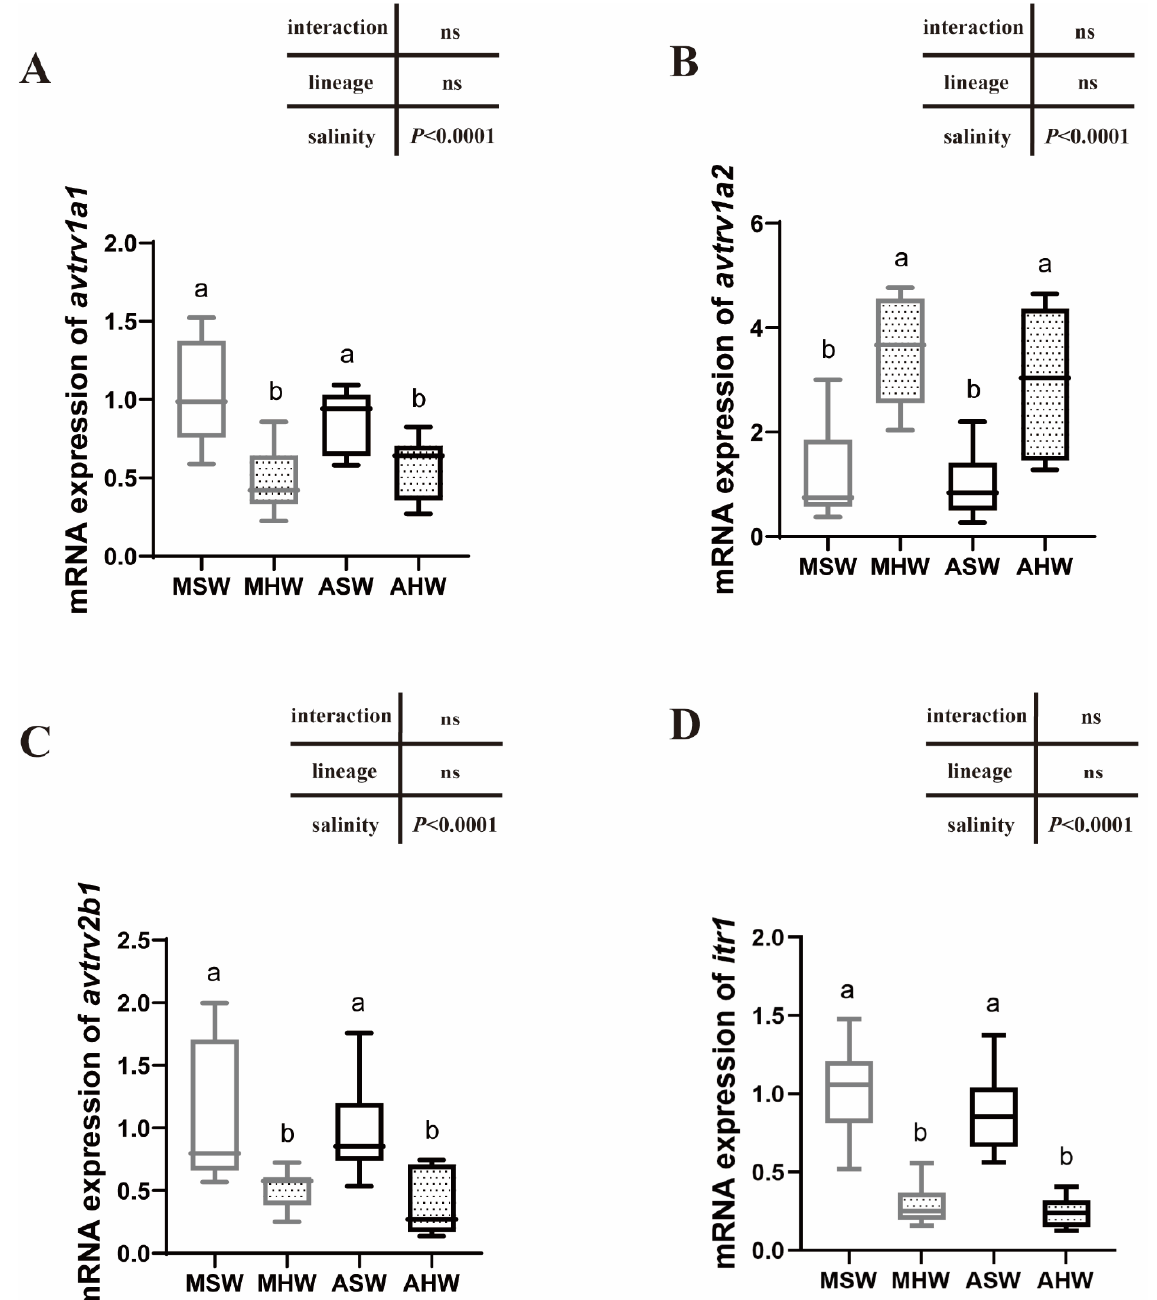
Figure 4. Relative avtrv1a1 (A) , avtrv1a2 (B) , avtrv2b1 (C) and itr1 (D) mRNA expression were measured in the posterior intestines of Mediterranean (M) and Atlantic (A) European sea bass maintained in seawater (SW) and hypersaline water (HW). Different letters denote significant differences between groups (two-way ANOVA followed by Tukey’s test, p < 0.05, n = 11). Data are represented as the median, first and third quartile (box), minimum and maximum values. ns: non significant.